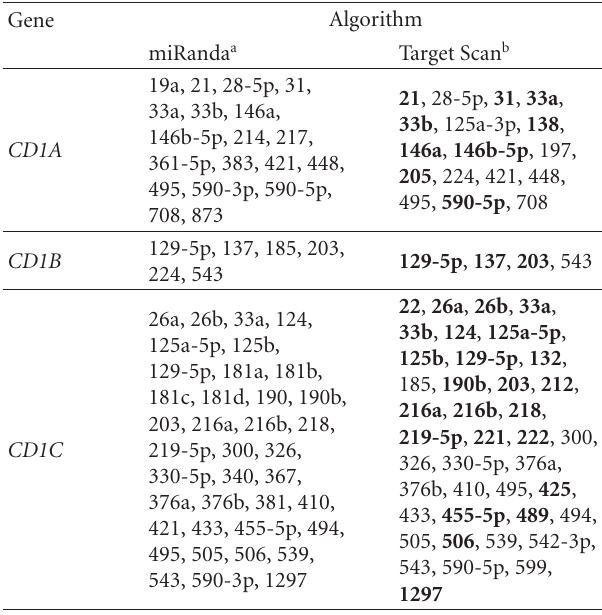
Table 1: miRNAs with putative binding sites in the 3 (cid:2) UTR of CD1A , CD1B, and CD1C genes.